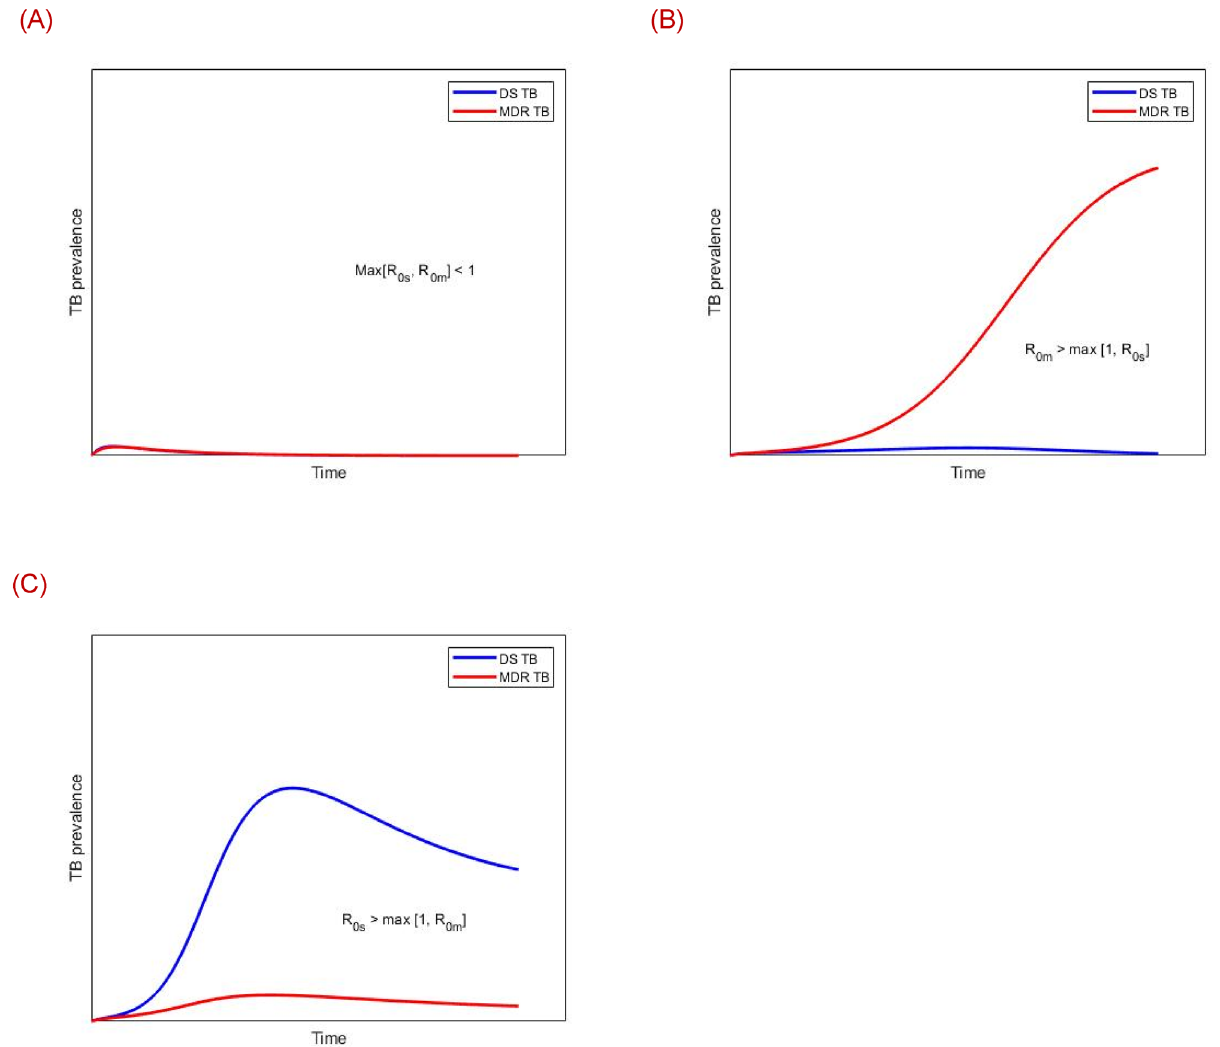
Figure 9. The effects of the strain-specific basic reproduction number on the dynamics of model